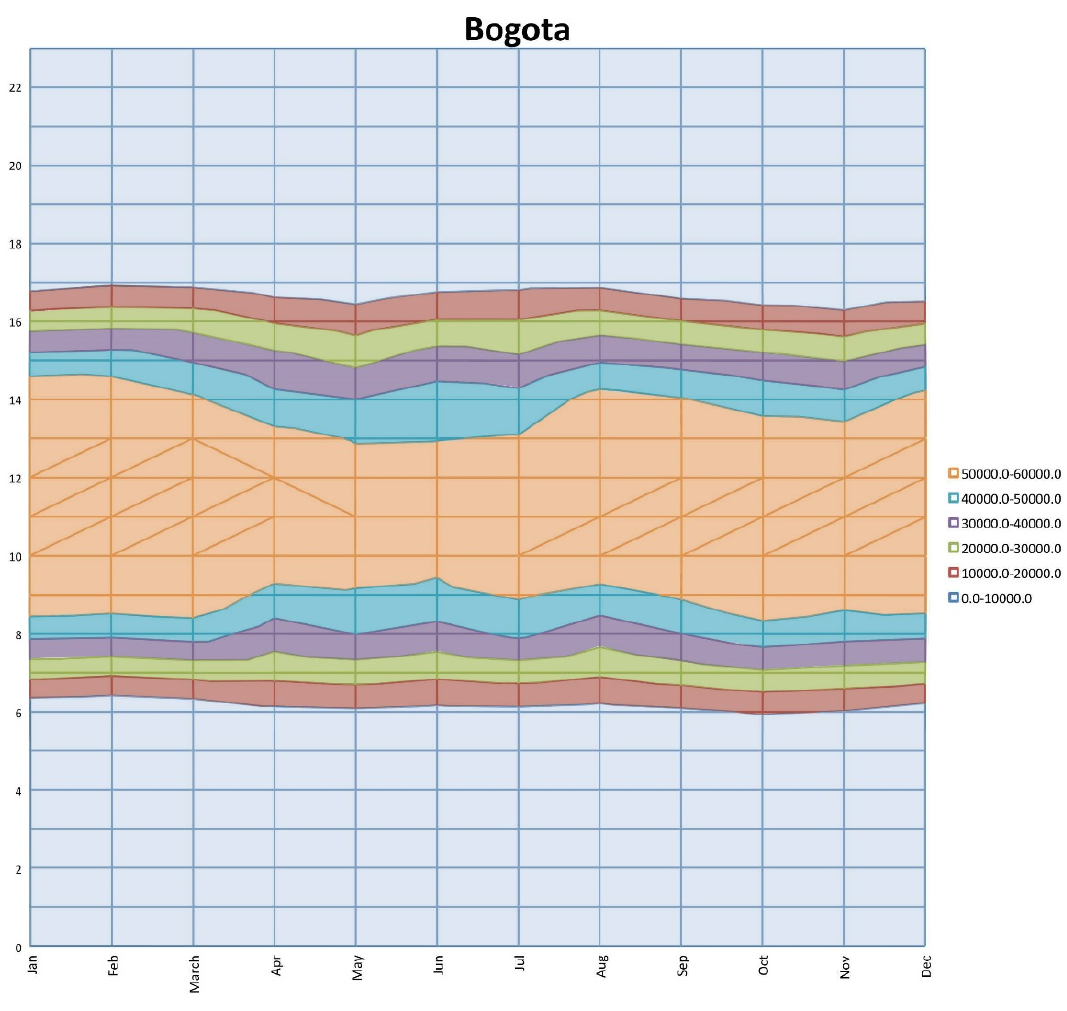
Figure 3. Average iluminance levels for the city of Bogotá. Source: Meteonorm